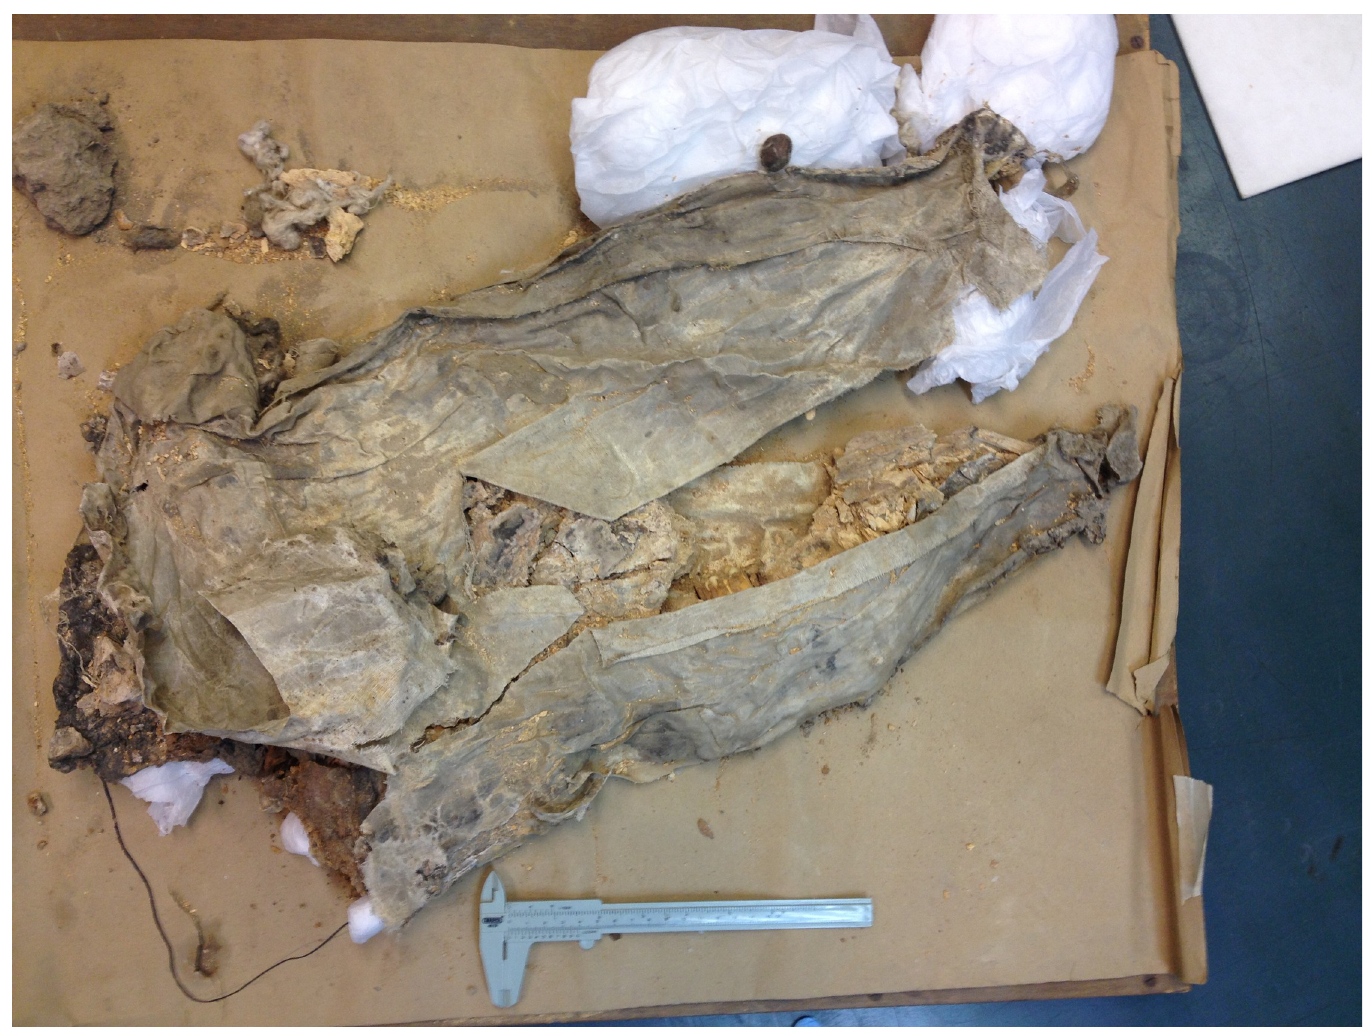
Fig 5. Cattle specimen BM2 (1935.01.16,17) “tooth 8” from PG789 “The Kings Grave” (Greenfield